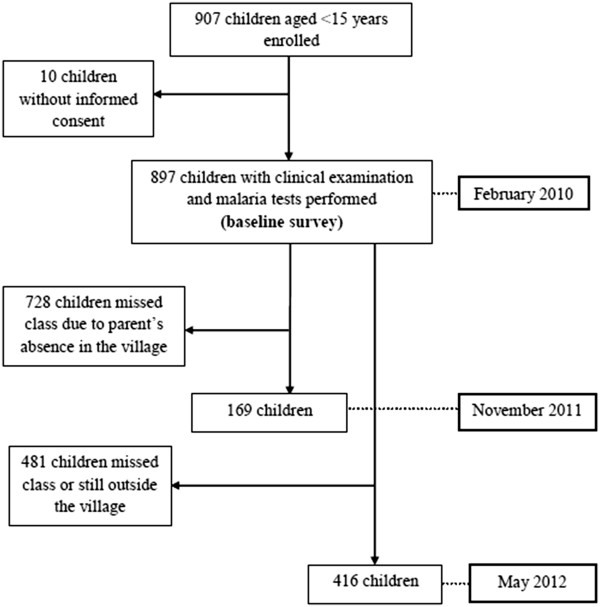
Flow chart detailing the study participation and compliance with finger-prick blood sampling in three villages of central Côte d’Ivoire.